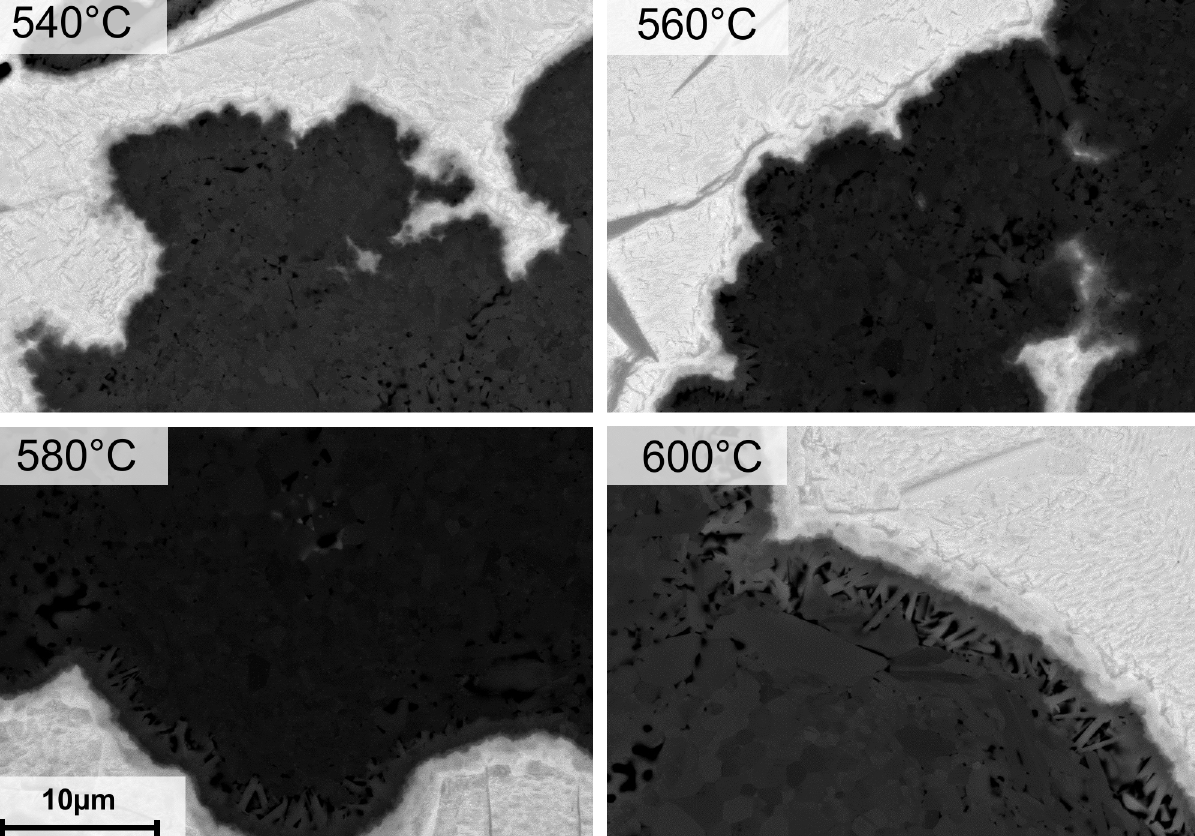
: Bright: Ti, dark: TiAl 3